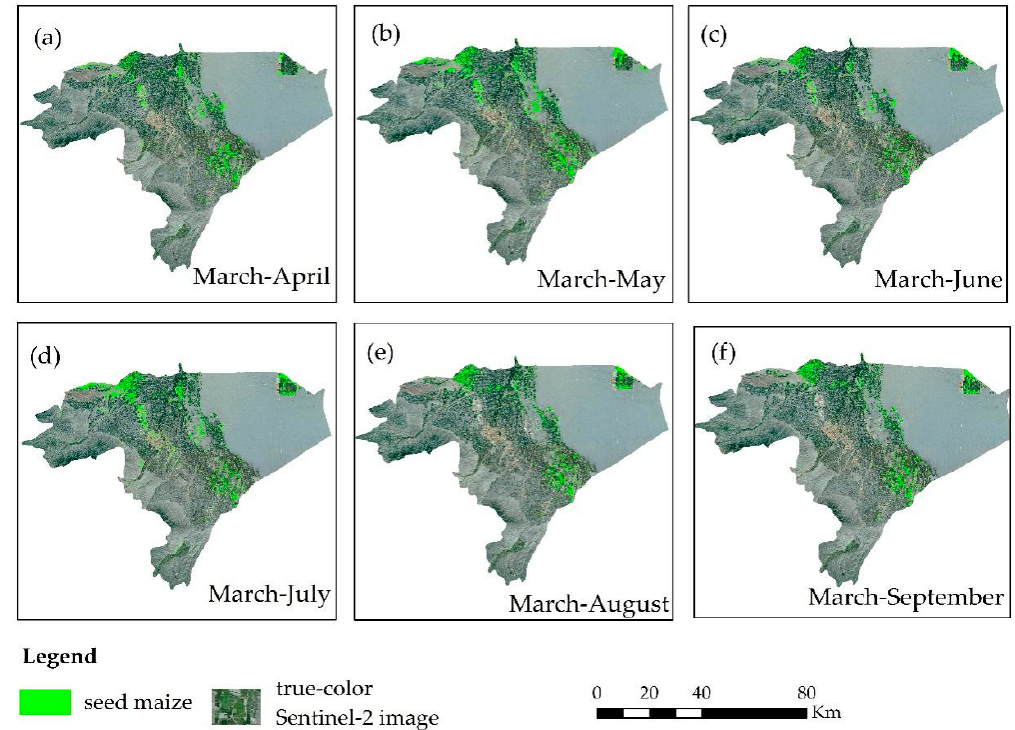
Figure 9. Distribution mappings of seed maize based on different time series lengths in Liangzhou. ( a ) March–April. ( b ) March–May. ( c ) March–June. ( d ) March–July. ( e ) March–August. ( f )